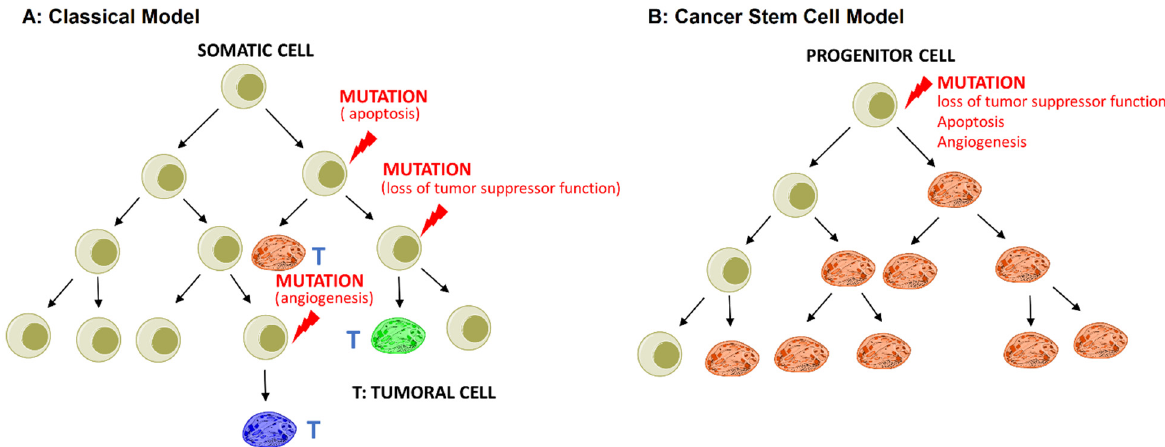
Figure 1. Two models of cancer development: ( A ) the stochastic or classical model; ( B ) the hierarchical or cancer stem cell model. Reprinted with permission from ref. [22], Copyright 2017 Elsevier.